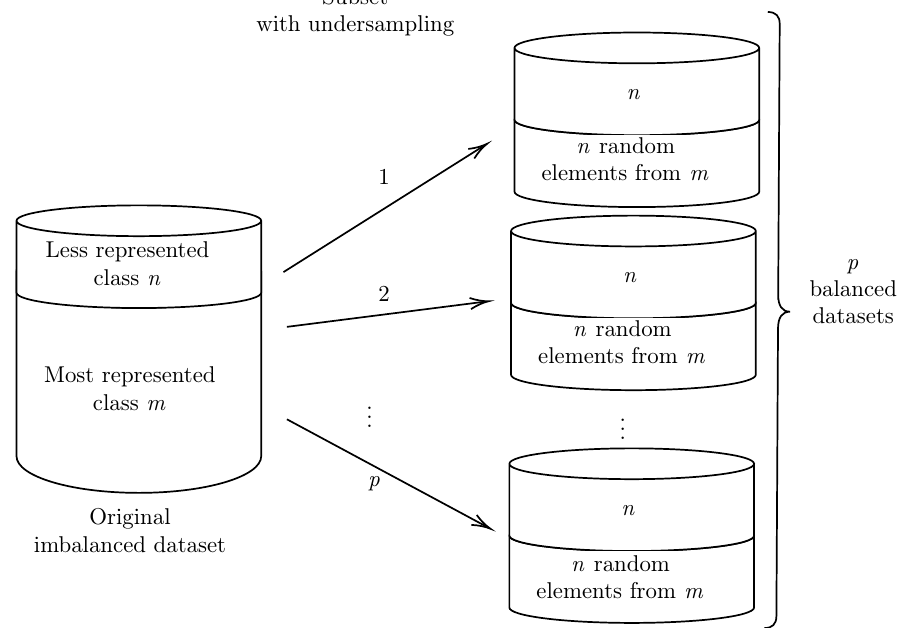
Figure 1. Producing multiple ( p ) balanced datasets through undersampling of the imbalanced dataset Figure 1: Undersampling process for imbalanced dataset with m and n elements of the most and less represented composed of a majority class ( m ) and a less represented, minority, class ( n ) by randomly removing classes, respectively. The process generates p smaller datasets by including n random elements from m . majority class elements until m = n